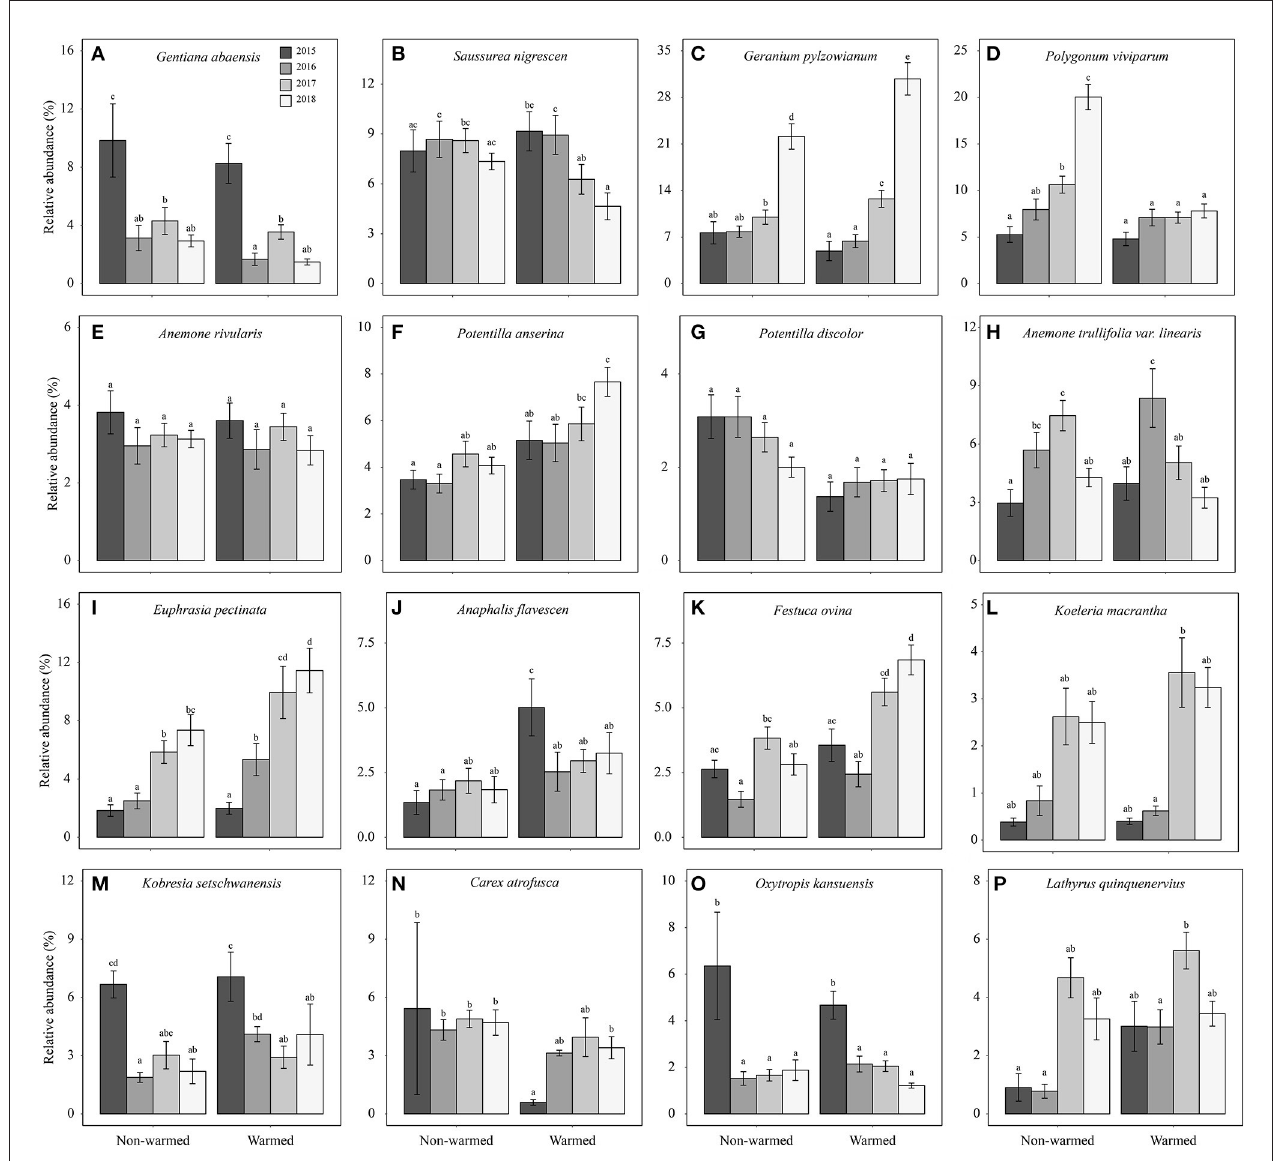
FIGURE 5 | Relative abundance of ten forbs ( Gentiana abaensis , Saussurea nigrescens , Geranium pylzowianum, Polygonum viviparum , Anemone rivularis, Potentilla anserine , Potentilla discolor , Anemone trullifolia var. linearis , Euphrasia pectinate, and Anaphalis flavescens , A–J ), two grasses ( Festuca ovina and Koeleria macrantha, K,L ), two sedges ( Kobresia setchwanensis and Carex atrofusca, M,N ), and two legumes ( Oxytropis kansuensis and Lathyrus quinquenervius, O,P ) in both non-warmed and warmed chambers from 2015 to 2018. Error bars = 1 standard error of mean. Different letters indicate a significant difference ( P < 0.05) between warmed and non-warmed